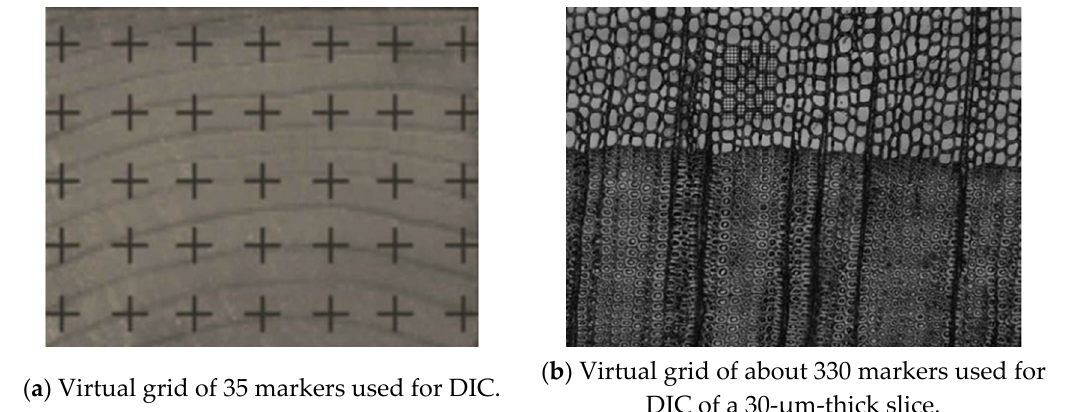
Figure 8. Images collected with DIC. The purposes of image collection: ( a ) measurement of transverse shrinkage, ( b ) measurement of shrinkage at the tissue level. From Han et al. [96] .